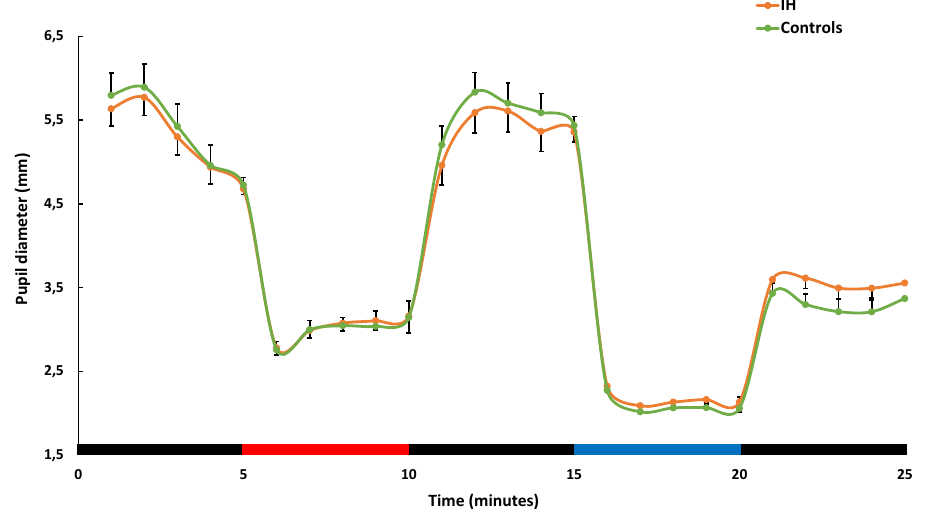
Figure 2. Pupil diameter throughout the pupillometry protocol in patients with IH and control subjects. Each point represents the mean pupil size in mm per minute ± Standard Error Mean. The bottom bar indicates the light exposure sequence: black: darkness, red: monochromatic red light (luminance: 375 cd/m 2 , irradiance: 14.75 log photons/cm 2 /s) and blue: monochromatic blue light (luminance: 375 cd/m 2 , irradiance: 14.57 log photons/ cm 2 /s); IH: patients with idiopathic hypersomnia; Controls: healthy subjects.